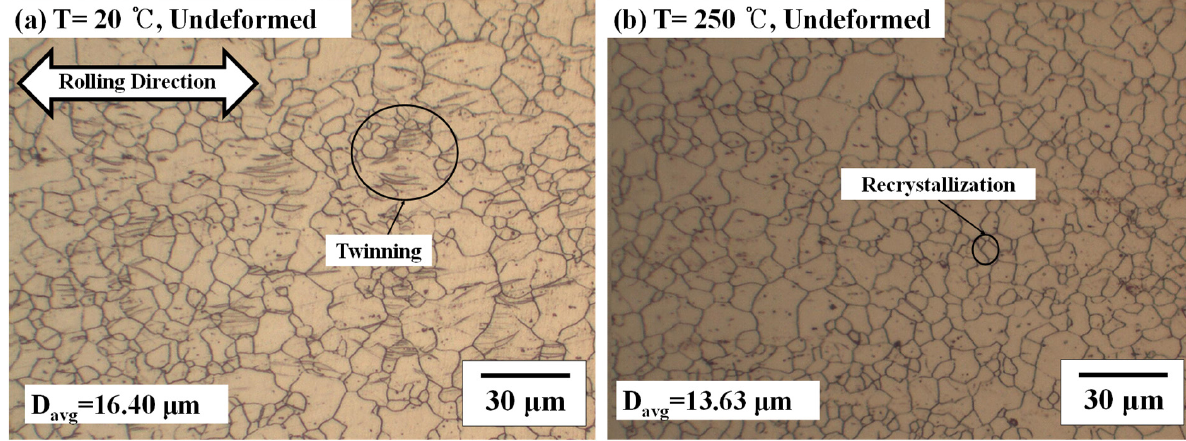
Figure 8. The initial microstructure of AZ31B at ( a ) 20 °C and ( b ) 250 °C.